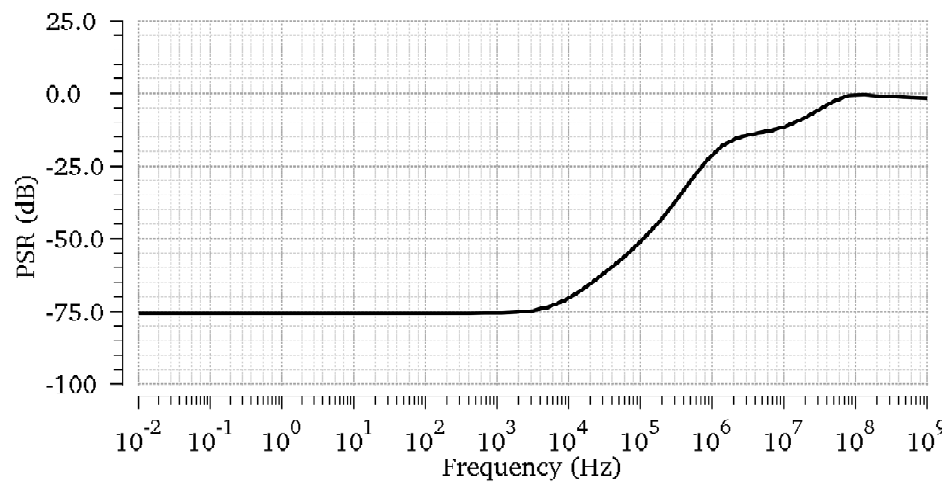
Figure 11. PSR simulations of the proposed OCL − LDO regulator for 𝐼 (cid:3013)(cid:3042)(cid:3028)(cid:3031) = 100 mA and 𝐶 (cid:3013) = 0 . Table 2. Performance comparison with prior-reported OCL-LDO regulators.